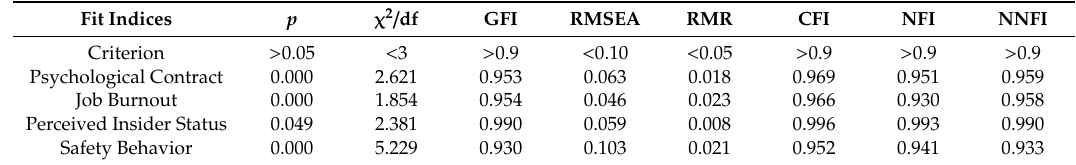
Table 4. Results of confirmatory factor analysis.